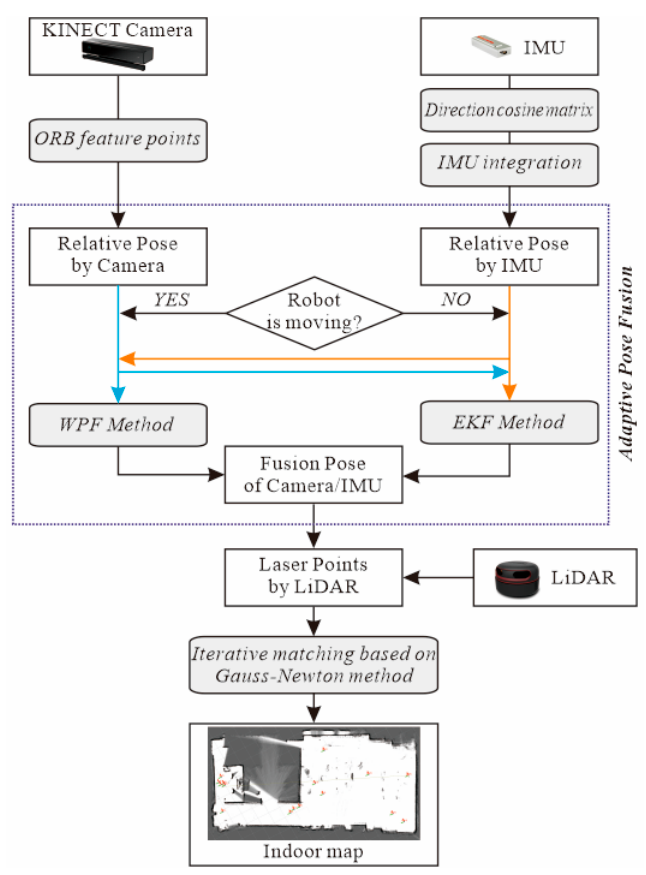
Figure 1. The architecture of the adaptive method of pose fusion for constructing an indoor map.